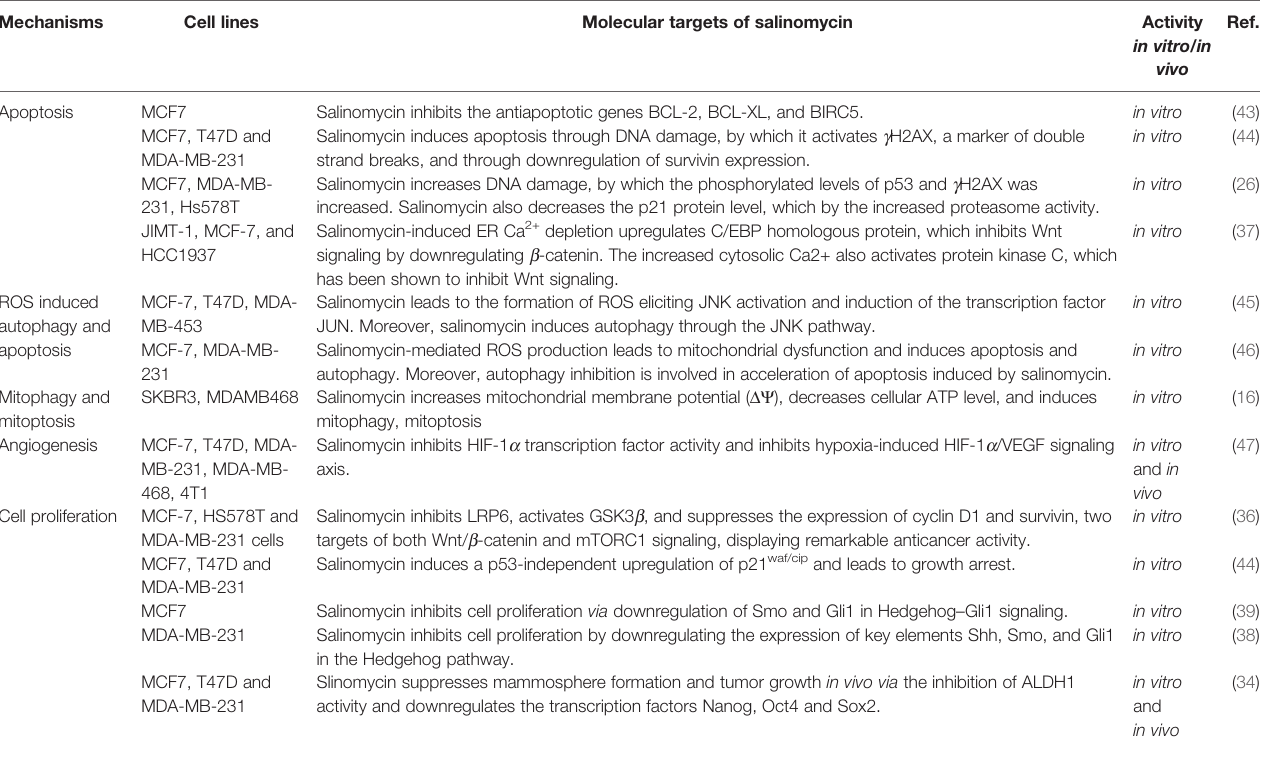
TABLE 2 | Anticancer mechanisms of salinomycin in BC